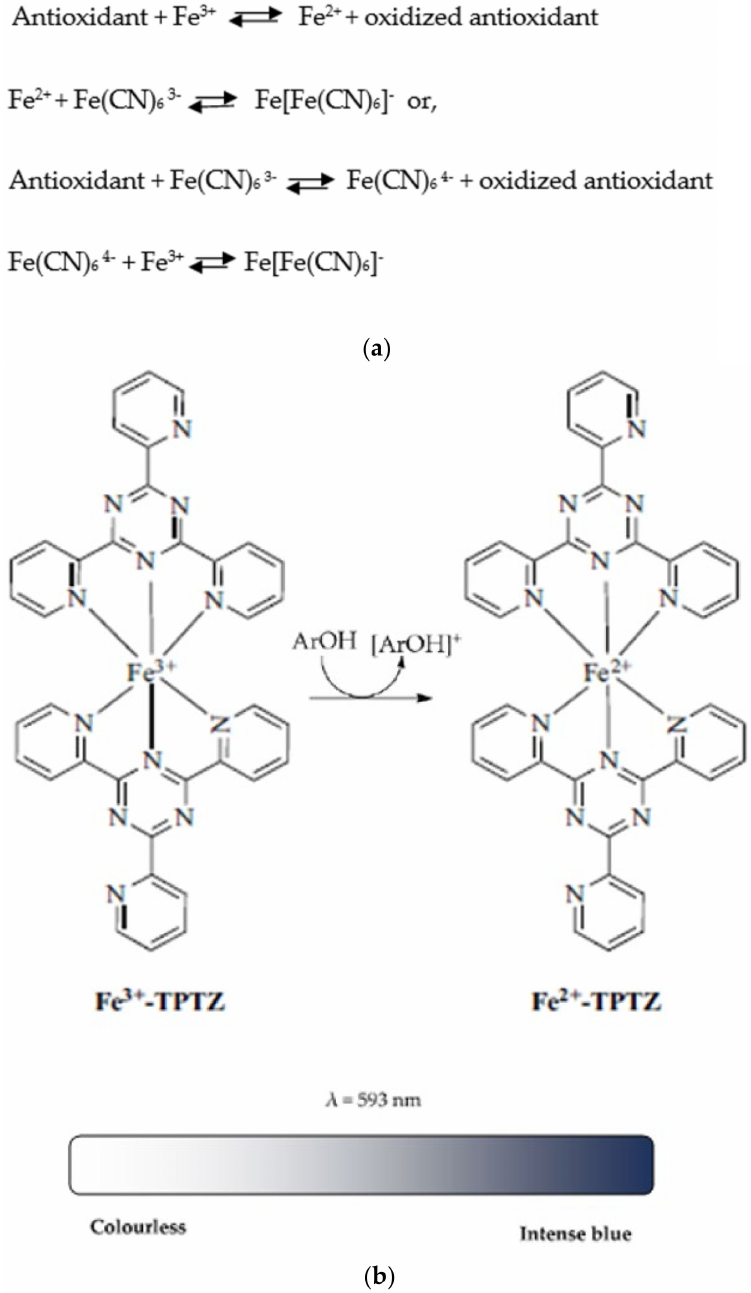
Figure 6. Ferric reducing antioxidant power (FRAP) reaction mechanism. ArOH represents a phenolic antioxidant and [ArOH] + an oxidised phenolic antioxidant ( a ); Chemical structure of the complexes involved in the chemical reaction and the colour change ( b